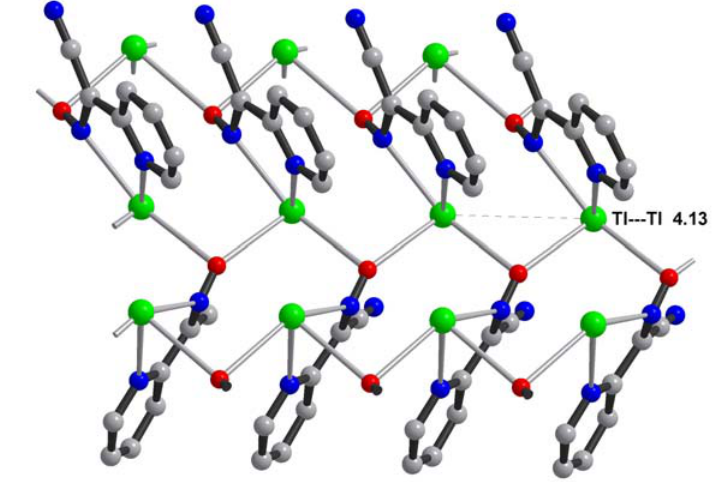
Figure 6. Organization of zigzag chain in 2D-coordination polymer in the structure of Tl(2PCO). H-atoms are omitted for clarity.